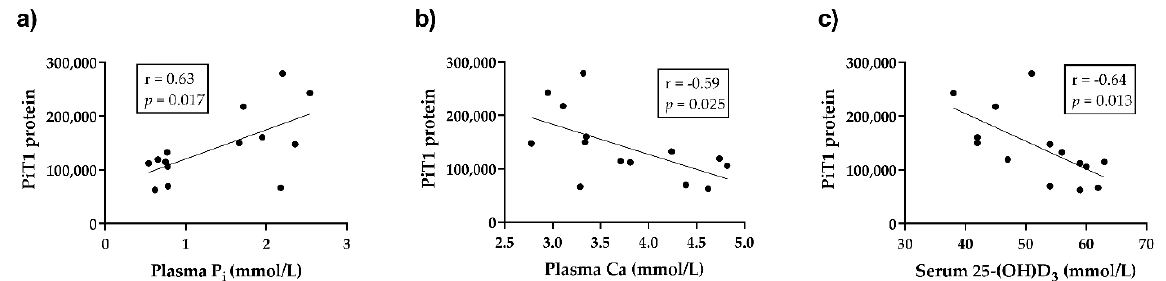
Figure 5. Linear regression of PiT1 protein expression with plasma P i ( a ) (PiT1 protein = (54,130 ± 19,486), plasma P i = (66,268 ± 30,620)), plasma Ca ( b ) (PiT1 protein = ( − 56,174 ± 21,950), plasma Ca = (352,119 ± 83,565)) and serum 25-(OH)D 3 ( c ) (PiT1 protein = ( − 5133 ± 1765), serum 25-(OH)D 3 = (409,943 ± 93,332)).